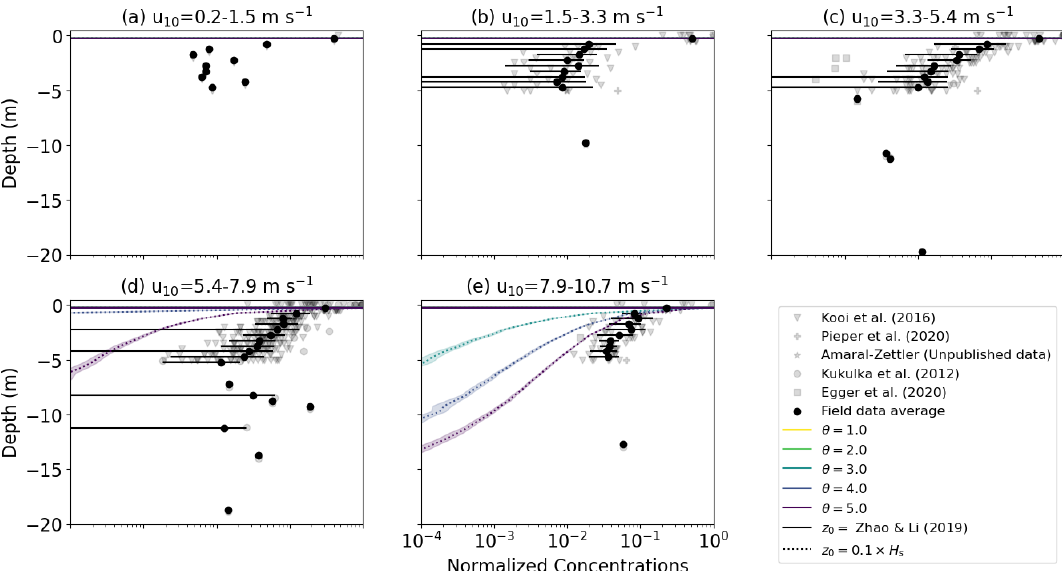
Figure D2. Vertical concentrations of buoyant particles for KPP diffusion under varying wind conditions with w r = 0 . 03ms − 1 . The KPP diffusion profile is calculated either with z 0 according to Eq. (12) or z 0 = 0 . 1 × H s and for θ ∈ [ 1 . 0 , 2 . 0 , 3 . 0 , 4 . 0 , 5 . 0 ] . The grey markers indicate field measurements, with darker shades indicating more measurements, while the binned field measurement average and standard deviation are shown by the black markers. Shading around the profiles indicates the profile’s standard deviation at each depth level.